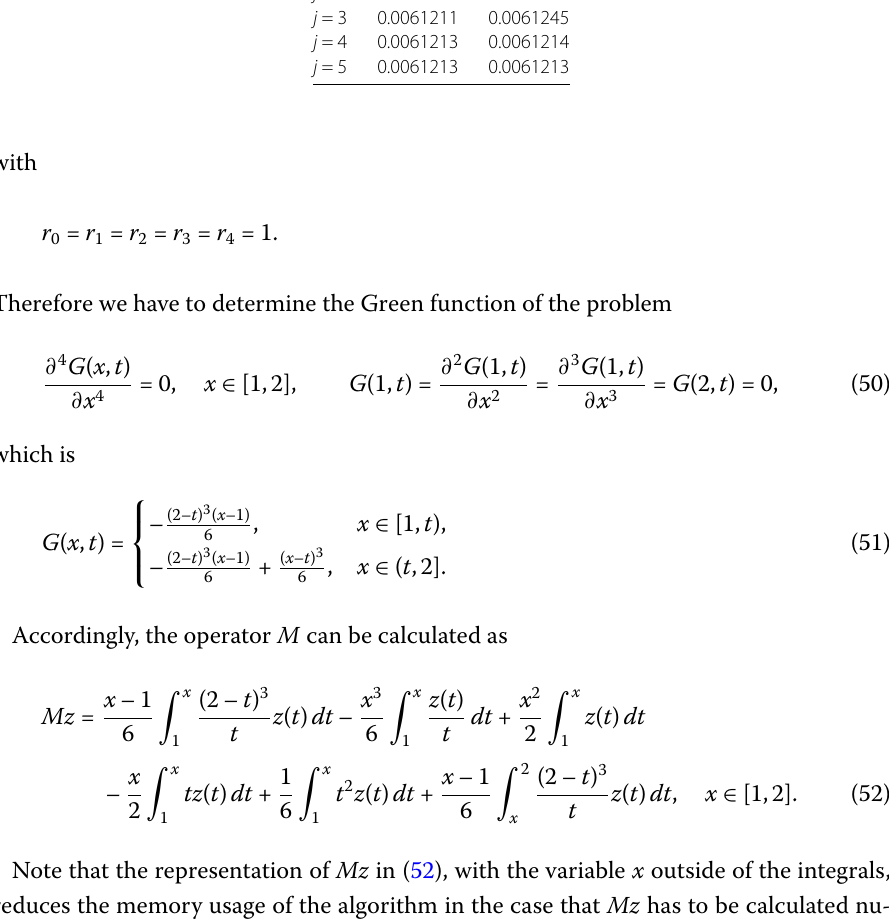
r ( M , M j z ) r ( M , M j z ) j = 0